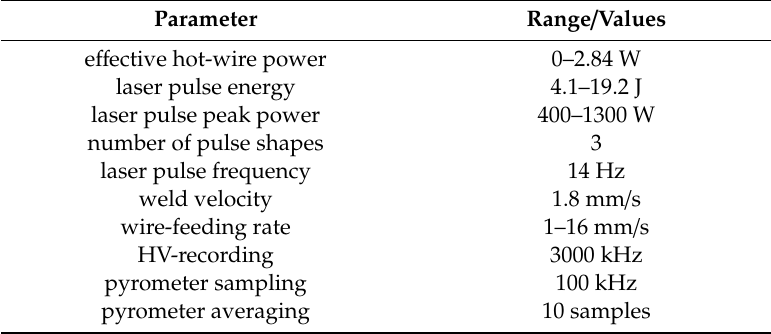
Table 4. Investigated parameters and further welding and monitoring conditions.